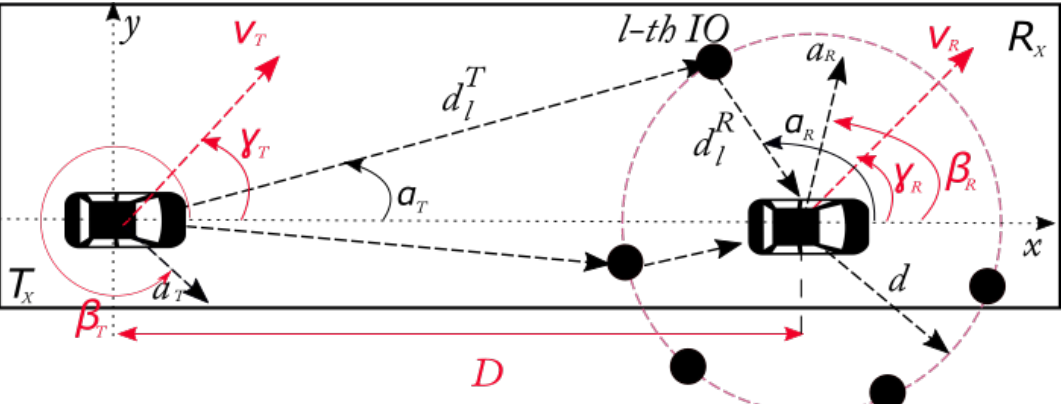
Figure 5. Single ring geometrical channel scattering model. The vehicle on the left side is the transmitter, while the vehicle on the right side represents the